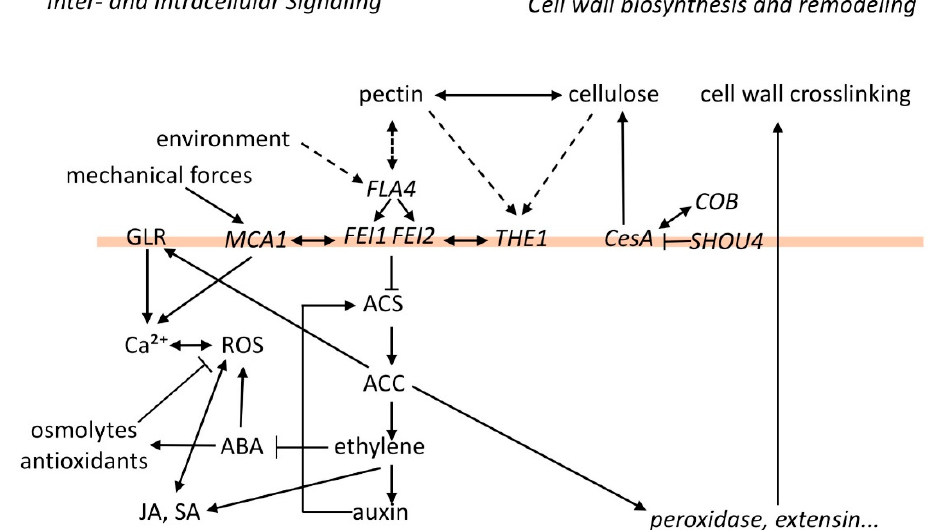
Figure 1. Hypothetical relations between cell wall polymers and stress signaling mediated by the FLA4-FEI pathway. At the center of the pathway FLA4 and the FEIs might repress 1-AMINOCYCLOPROPANE 1-CARBOXYLIC ACID SYNTHASE (ACS), which could affect various other growth regulators, including abscisic acid (ABA), auxin, ethylene, jasmonic acid, and salicylic acid. ABA regulates osmotic and oxidative stress responses. ACC influences intracellular calcium by activating GLUTAMATE RECEPTOR HOMOLOGS (GLRs) and also affects transcription of cell wall peroxidases and extensins, which could crosslink cell wall polysaccharides. There appears to be a tight interaction between the FLA4-FEI pathway and THE1 as well as MCA1 in cell wall integrity (CWI) sensing. The physical interactions that connect cell wall polymers with the FLA4-FEI pathway are presently unknown (dashed arrows).